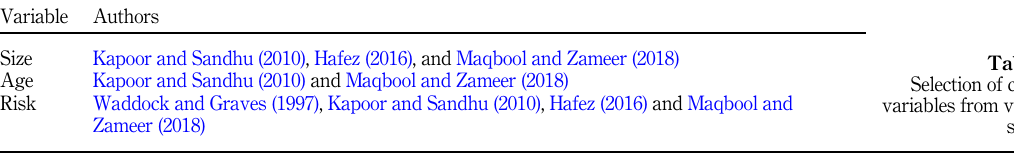
Table 2. Selection of dependent variables form various studies